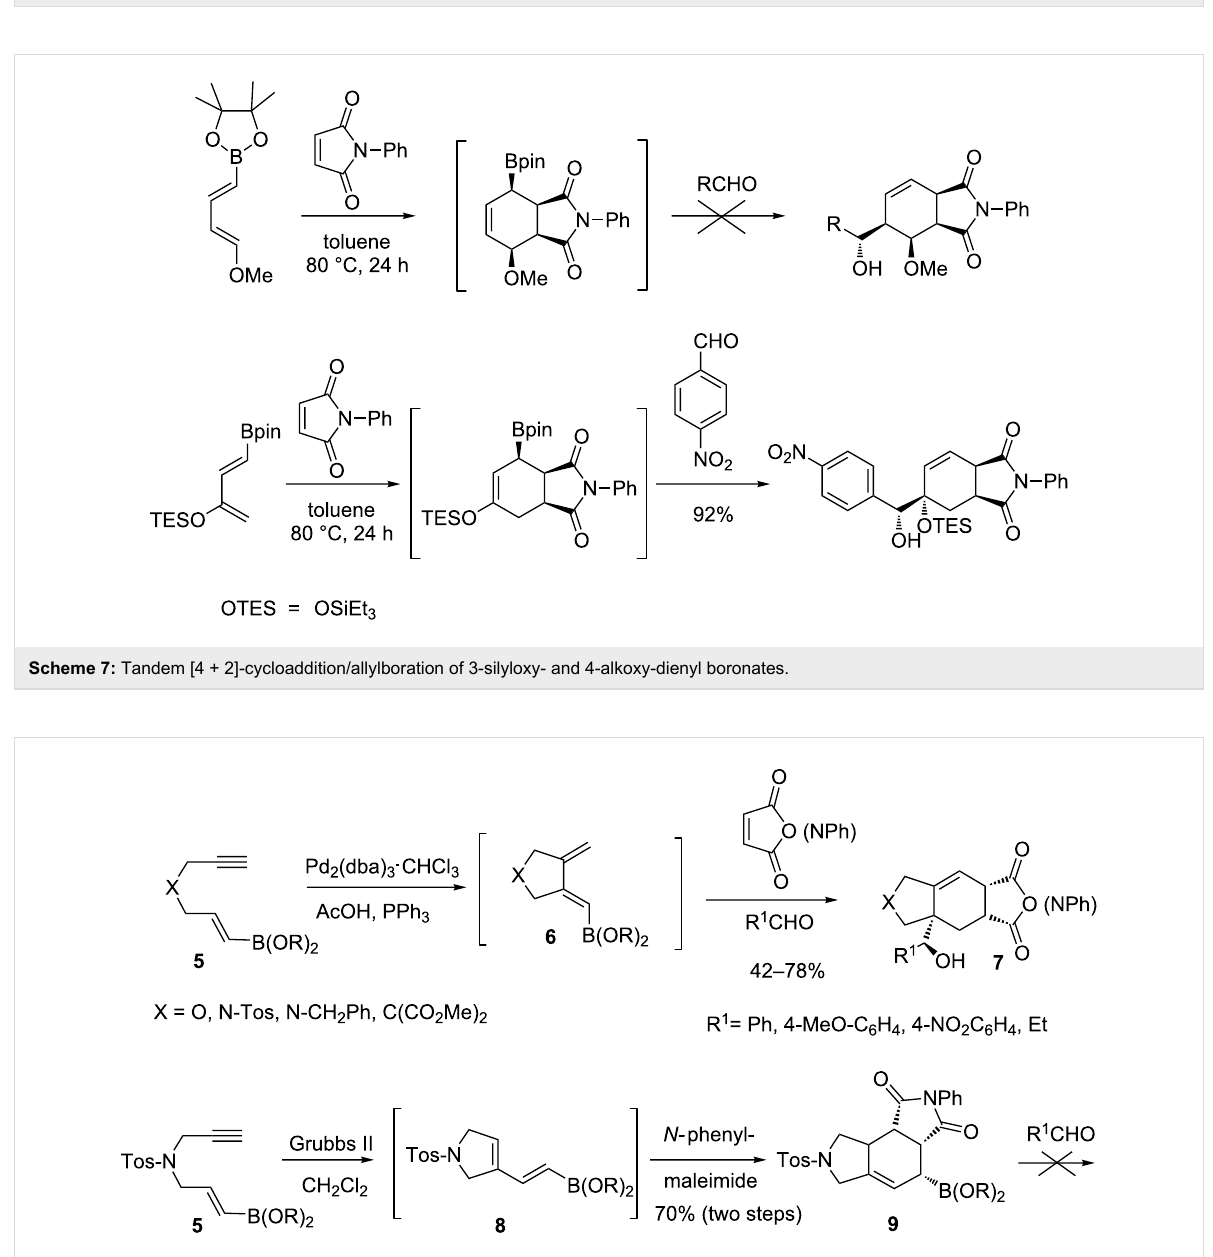
Scheme 6: Asymmetric synthesis of a α -hydroxyalkylcyclohexane.